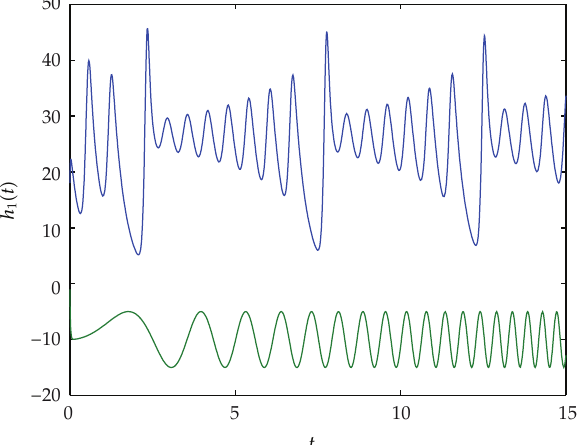
Figure 7: Recoverd message of h 1 (cid:3) t (cid:4) ∈ (cid:6) 2 × 1 described in in the receiver of (cid:3) 3.7a (cid:4) – (cid:3) 3.7e (cid:4) .